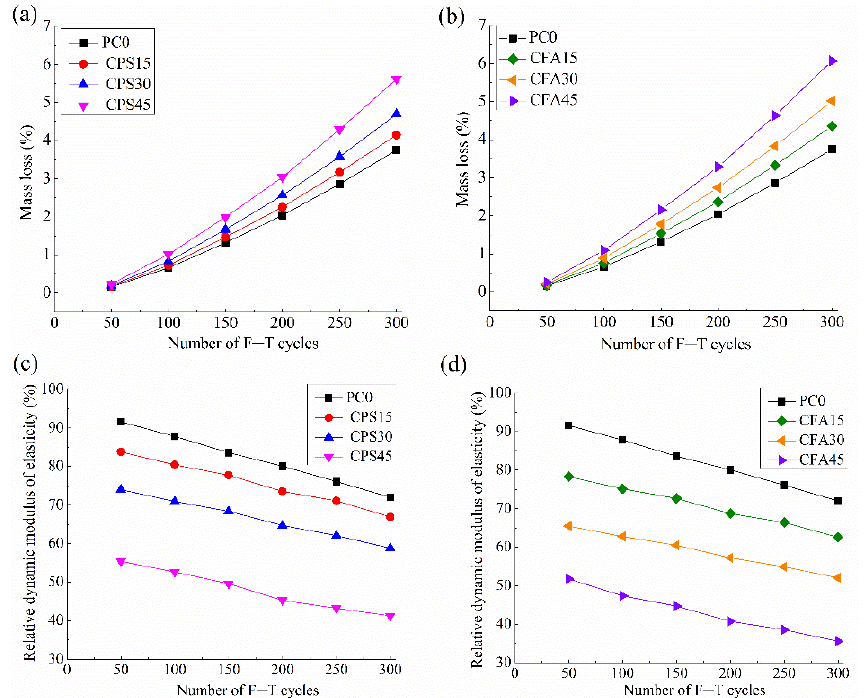
Figure 3. Frost resistance results of concretes hydrated at 28 days; ( a , b ) mass loss of FGPS concrete and fly ash concrete, ( c , d ) relative dynamic elastic modulus of FGPS concrete and fly ash concrete.